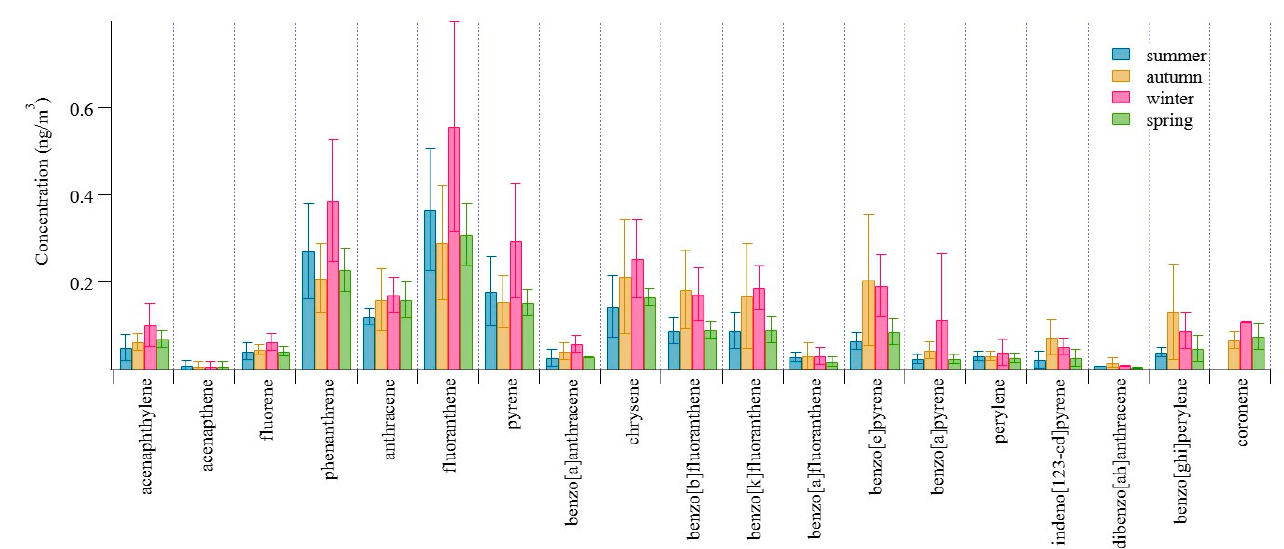
Figure 2. The abundance of detected PAH components in various seasons (unit: ng/m 3 ; blue: summer, yellow: autumn, red: winter, green: spring).